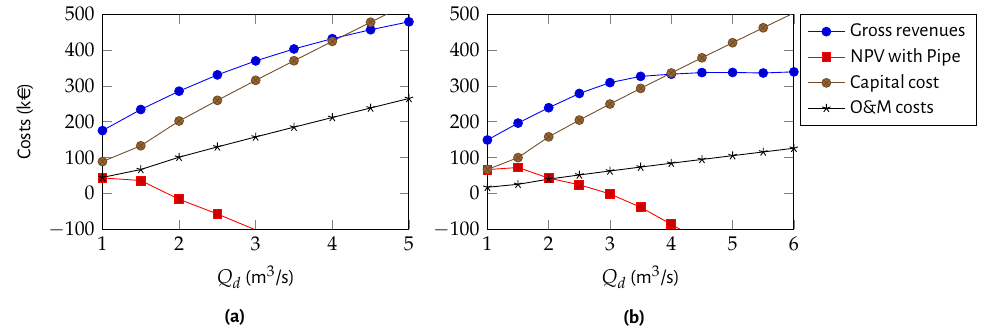
Figure7. Economicanalysisresultsasafunctionofthedesigndischargewithandwithoutthepipecost: (a)Kaplan,(b)Propeller Figure 7. Economic analysis results as a function of the design discharge with and without the pipe cost: ( a ) Kaplan, ( b )